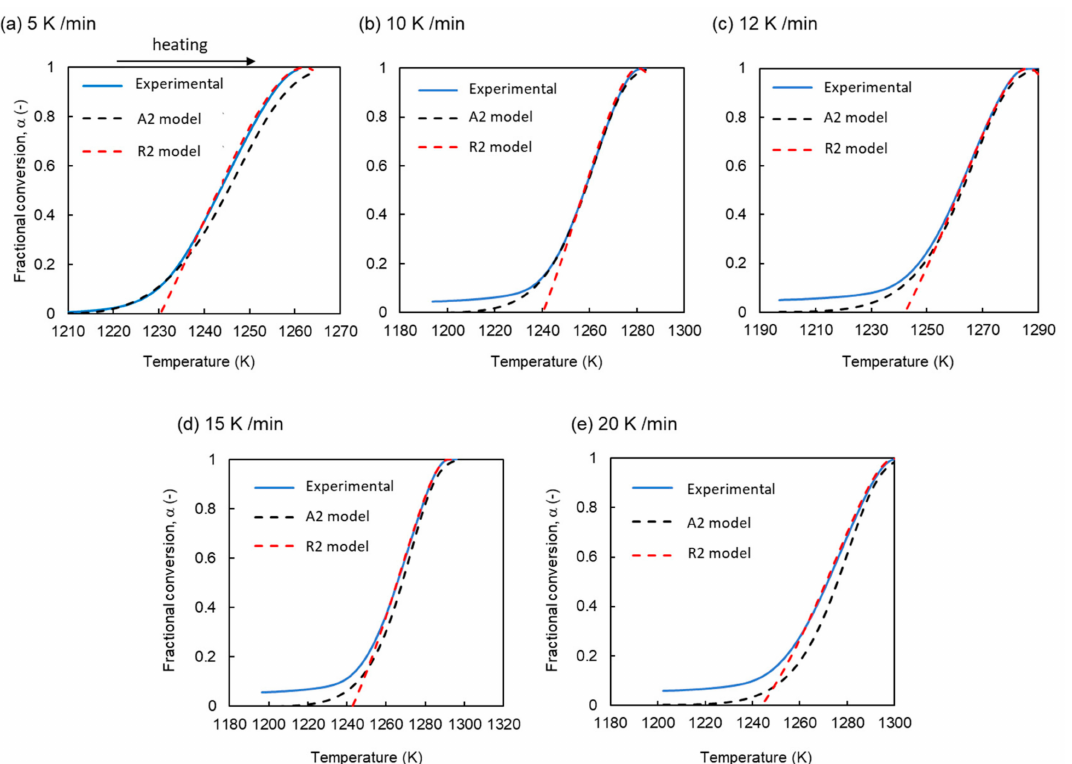
Figure 6. Temperature variation of the fractional conversion, α , of the long-term cycled sample during the HC mode for experimental (blue curve) and predicted reaction models (black and red curves for A2 and R2 models, respectively); the data of heating rate ( a ) 5 K/min, ( b ) 10 K/min, ( c ) 12 K/min, ( d ) 15 K/min, ( e ) 20 K/min. The curves are compared in these figures for the validation of the predicted reaction